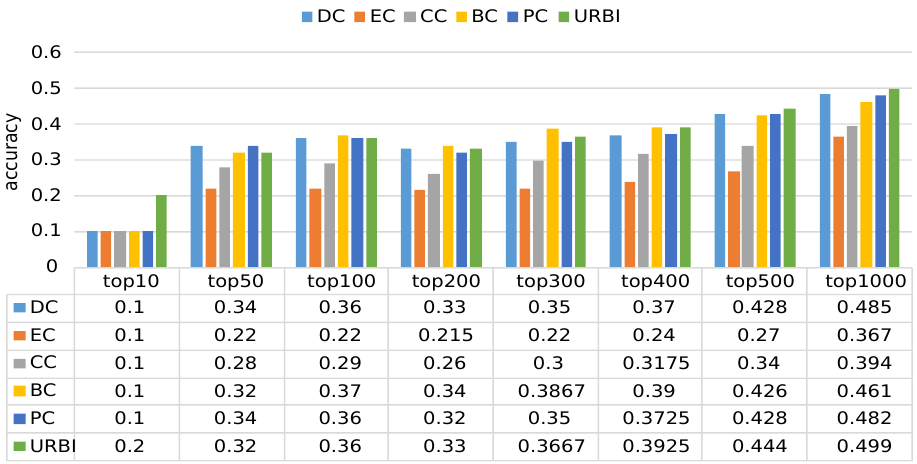
Figure 9. This figure depicts the experimental results of dataset No.9, which contains 8213 book